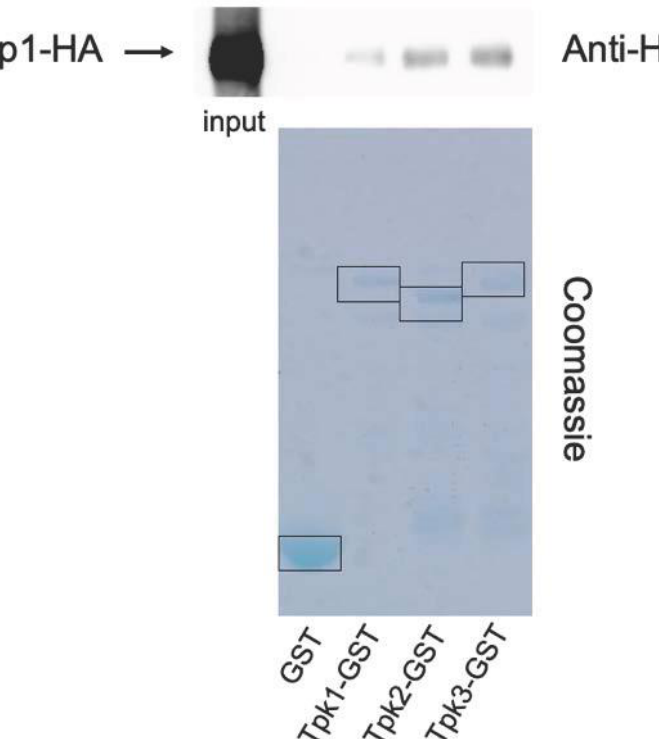
FIGURE 4: Gap1 interacts in vitro with the three catalytic subunits of PKA. The indicated GST-tagged proteins were purified from bac- teria using glutathione-Sepharose beads and incubated with cell extracts from yeast cells expressing Gap1-HA. GST-pull down assay, followed by SDS-PAGE, Western blotting de- tection with peroxidase coupled anti-HA anti- body demonstrates interaction between Gap1-HA and Tpk1-GST, Tpk2-GST and Tpk3- GST. No Gap1 was recovered using GST